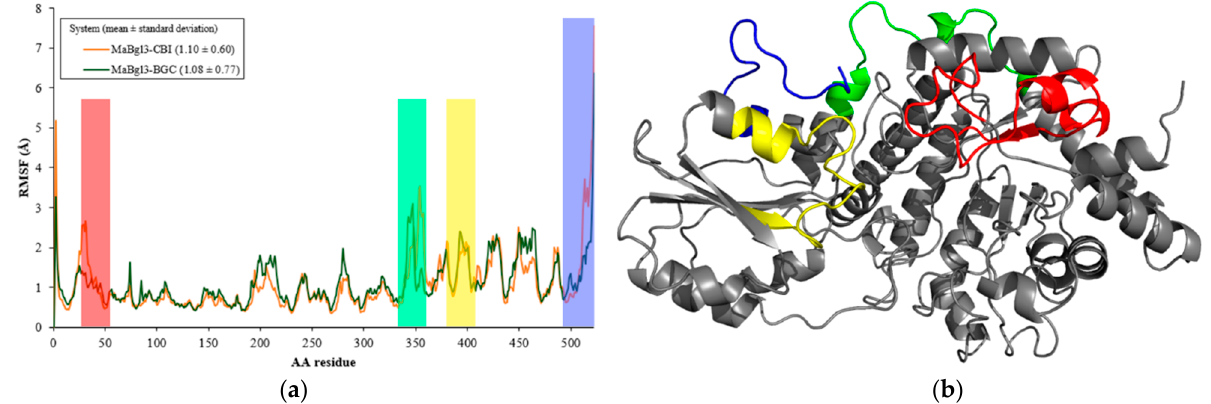
Figure 6. ( a ) RMSF vs. amino acid (AA) residue plot for the main structure of both systems during 100 ns of MD simulations. ( b ) MaBgl3 structure with flexible regions colored and other regions colored in grey.